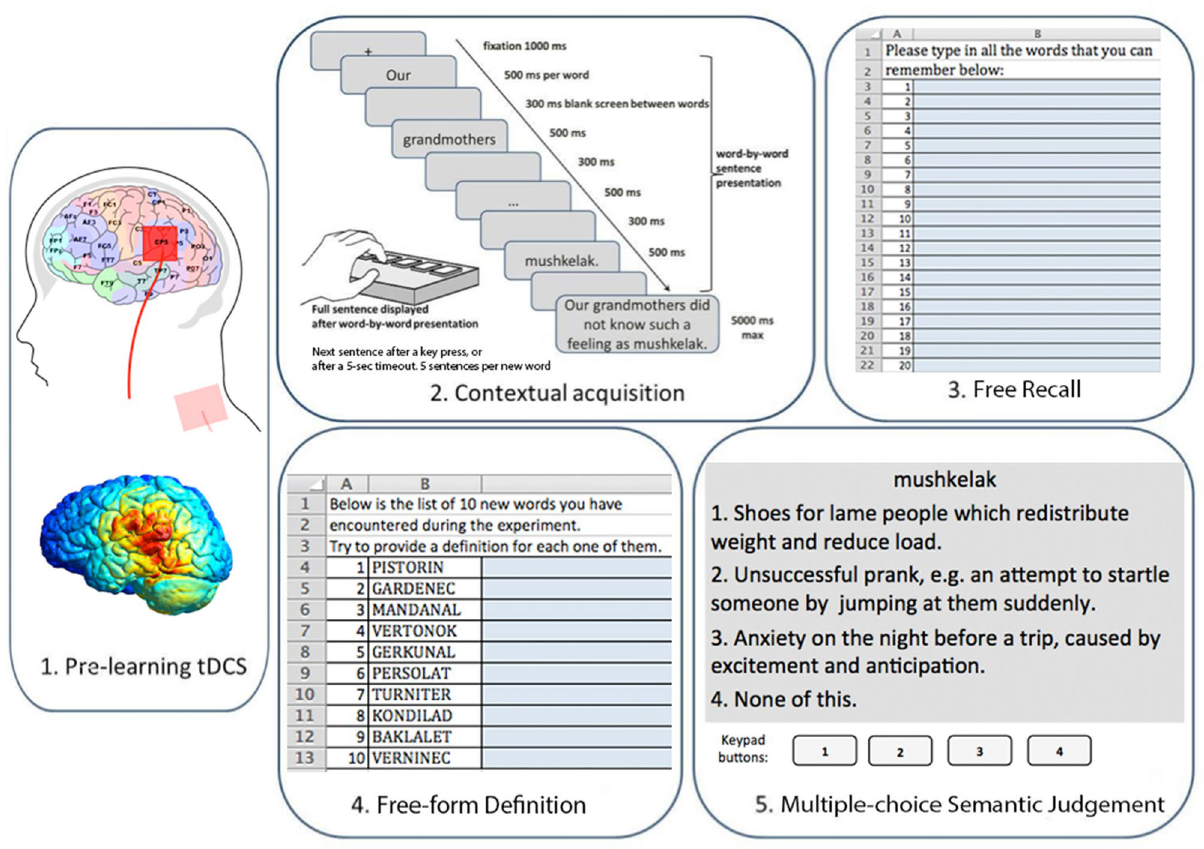
Figure 1. Diagram of main experimental procedures. (Note that stimulus translation from Russian into English is approximate, see Methods for of the current flow, the main effects of the present stimulation here should still be associated with the temporo- parietal cortex within Wernicke’s area, where the current intensity is highest. In Fig. 1 (left lower) we show the simulation model of the current spread for the current montage and stimulation settings, built using SimNIBS v. 3.1.2 software (https ://simni bs.githu b.io/simni bs/build /html/index .html; 55); note that neuroanatomically the model is identical for both stimulation polarities, only the current direction is different. The three groups of participants received sham (placebo), cathodal, or anodal stimulation while seating with open eyes without any distracting conditions. The stimulation procedure lasted for 15 min, including a 30-s ramp- up and a 30-s ramp-down periods. The sham stimulation procedure corresponded to the one described above except that the current was applied only briefly (30 s) at the beginning and the end of the session: during the first and last 30 s of the 15-min tDCS session, an electric pulse of a triangular shape with a maximum of 1.5 mA was applied. The main sensation of stimulation is associated with changes in current intensity 56 . In placebo stimula- tion condition, the subjects are exposed to the same changes in current strength as in real anodal or cathodal conditions, but the phase of long-term exposure to current is excluded. Thus, the sham session participants had a generally similar experience to that of real tDCS, which normally amounted to a painless tingling sensation during the initial and final seconds of the stimulation session. Immediately after the tDCS application, the participants underwent contextual acquisition of novel words. They were seated in front of a computer monitor and instructed to read stimulus sentences carefully. Each sentence started with a word-by-word presentation, followed by the presentation of the entire sentence on the screen to ensure full understanding. Participants had to press the spacebar with their index finger of the left hand after reading the complete sentence. The duration of the sentence presentation was 5000 ms. Then a fixation cross (“+”) appeared in the center of the screen for 1000 ms and the presentation of the next sentence began. The sets of sentences were separated from each other by a triple crosshair (“+++”) presented for 2000 ms and another fixation cross displayed for 1000 ms. Each word was presented for 500 ms following a 300-ms empty screen between words within one sentence. A short training block was presented prior to the main part of the experiment. The main experimental block was divided into two sub-blocks, with a short break between them to reduce fatigue. The average duration of the acquisition phase was 25 min. The contextual acquisition part of the experiment was implemented in NBS Presentation 20.0. The background colour was grey (RGB: 125, 125, 125), the text colour was black (RGB: 0; 0; 0), font—Arial, font size—24. Stimulation of language cortices may produce a complex pattern of behavioural outcomes, therefore a battery